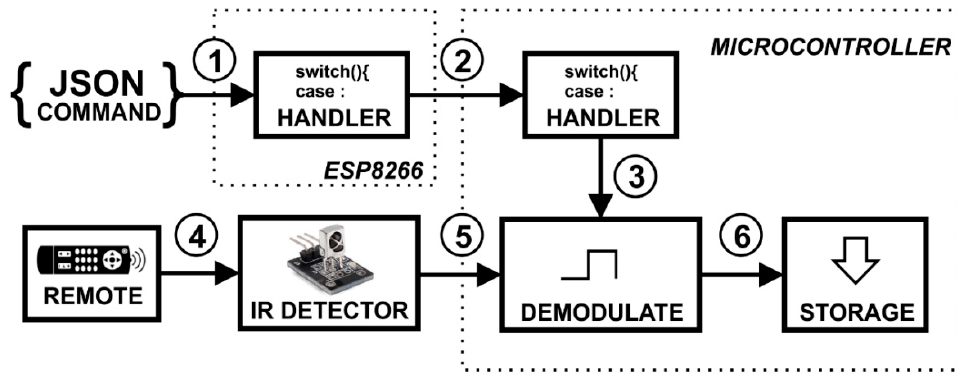
Figure 5. Detection and storage of an IR command.